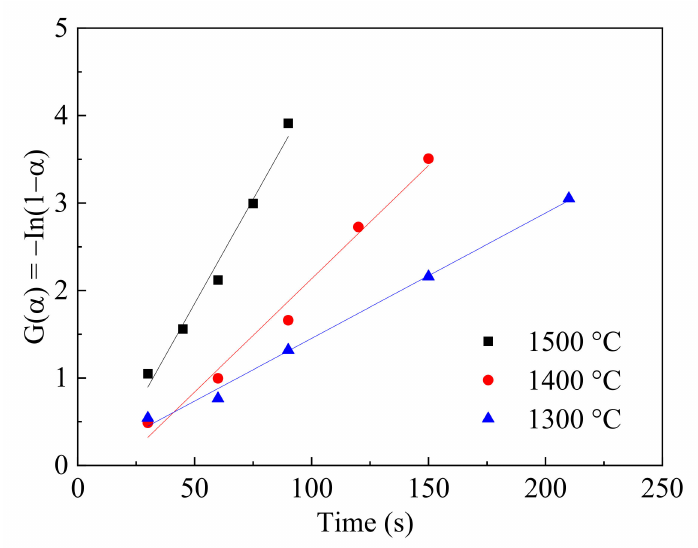
Figure 12. Linear fitting of G( α ) and time at different temperatures. ln k ( T ) was obtained from the natural logarithm of the slope of the fitting line from